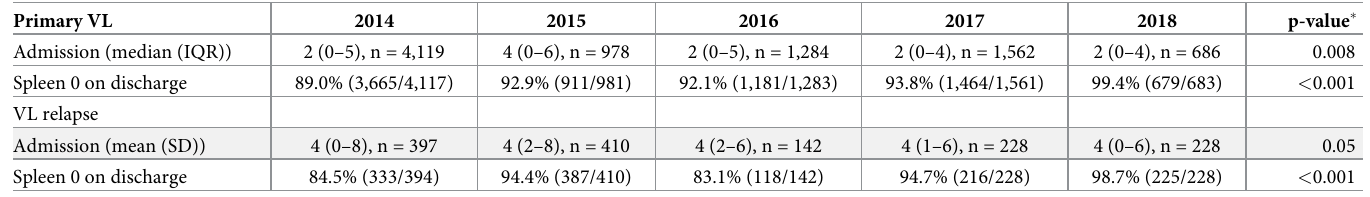
Table 4. Spleen size (distance in centimetres from left costal margin to tip of spleen) on admission and discharge for primary and relapse visceral leishmaniais (VL) patients at Me´decins Sans Fronti è res (MSF) centres in South Sudan, 2014–2018 (from patient-level data). Primary